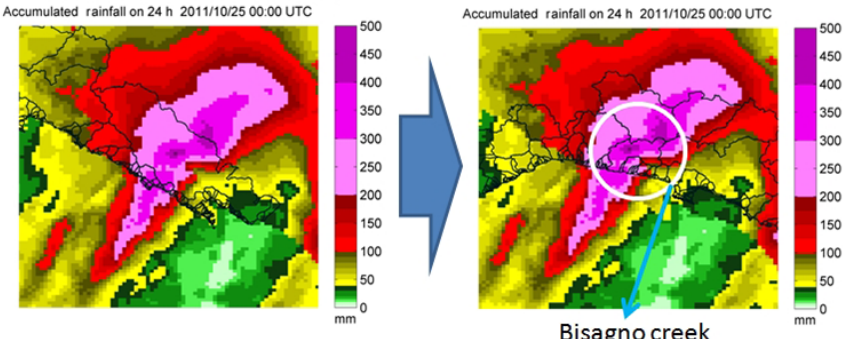
Figure 3. The 25 October 2011 accumulated rainfall over 24h. Left panel indicates observed rainfall field and the right panel the hypothetical rainfall field obtained by the rigid translation of the observed rainfall field from the original position to the Bisagno creek.